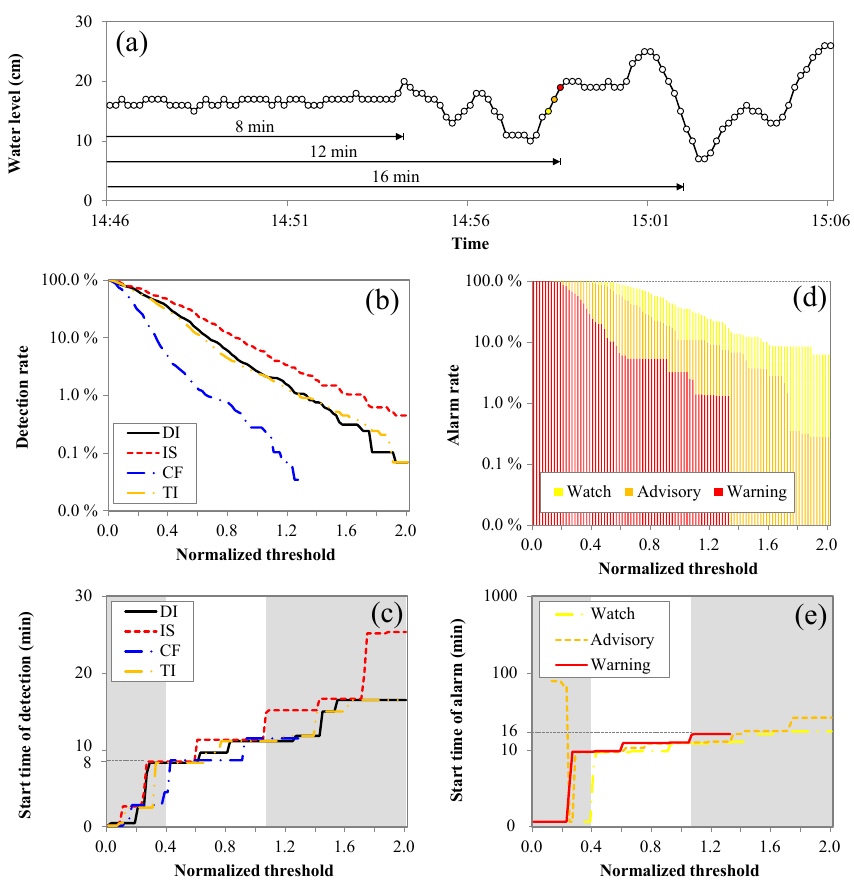
Figure 10. Examples of the tsunami detection algorithm using the calibrated parameters when the normalized threshold changes from zero to two with 0.02 intervals. (a) The 2011 T¯ohoku tsunami recorded in the Ulleung-do surge gauge. The colored circle represents the start point of each alarm (red: warning, orange: advisory, yellow: watch) when the normalized threshold is set to one (TH DART = 5cm, TH IS = 0.01cms − 1 , TH CF = 4, TH TIDE = 5 cm). For each index (DI, IS, CF, and TI), (b) detection rate during the event period and (c) start time of detection are given. For each alarm (warning, advisory, and watch), (d) alarm rate during the event period and (e) start time of alarm are given. The gray shade region marks the range of the normalized threshold where a false or missed alarm